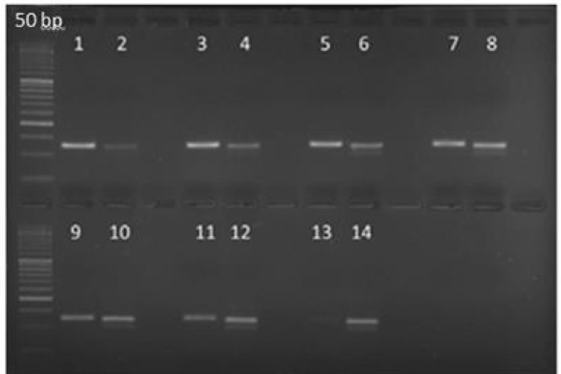
Figure 2. Methylation profiling of HLA-G and ICAM-1 by methylation-specific PCR (MSP). Results of MSP on HLA-G and ICAM-1 promoters from gDNA isolated from with healthy lifestyle habit and without healthy lifestyle habit of POR patients. (M = methylated primer, UN = unmethylated primer). The 1 and 2 bands are for MSP positive control of UN methylated gDNA (10%). The 7 and 8 bands are for MSP positive control of UN methylated gDNA (20%). The 13 and 14 bands are for MSP positive control of fully methylated placental gDNA (100%). The 3, 4, 9 and10 bands are for HLA-G and the 5, 6, 11 and12 bands are for ICAM-1. The (3, 4) and (5, 6) bands are for POR patients with healthy lifestyle habits and (9, 10) and (11, 12) bands are for POR patients without healthy lifestyle habit. Columns 1, 3, 5, 7, 9, 11 and 13 belong to the patient sample with unmethylated primer and columns 2, 4, 6, 8, 10, 12 and 14 belong to the patient sample with methylated primer. Sample No. 1, 2, 7, 8, 13, and 14 bands are positive controls (DNA samples of fertile women). Sample No. 3, 4, 5, 6, 9, 10, 11, and 12 belong to different patient